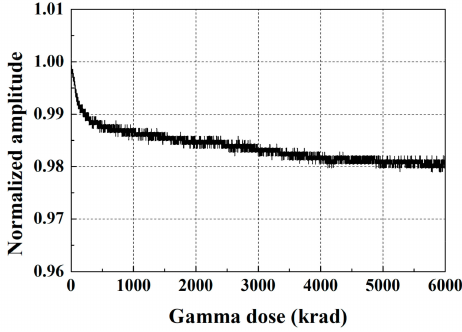
Figure 11. The normalized amplitudes of the incident wave as a function of gamma radiation dose.